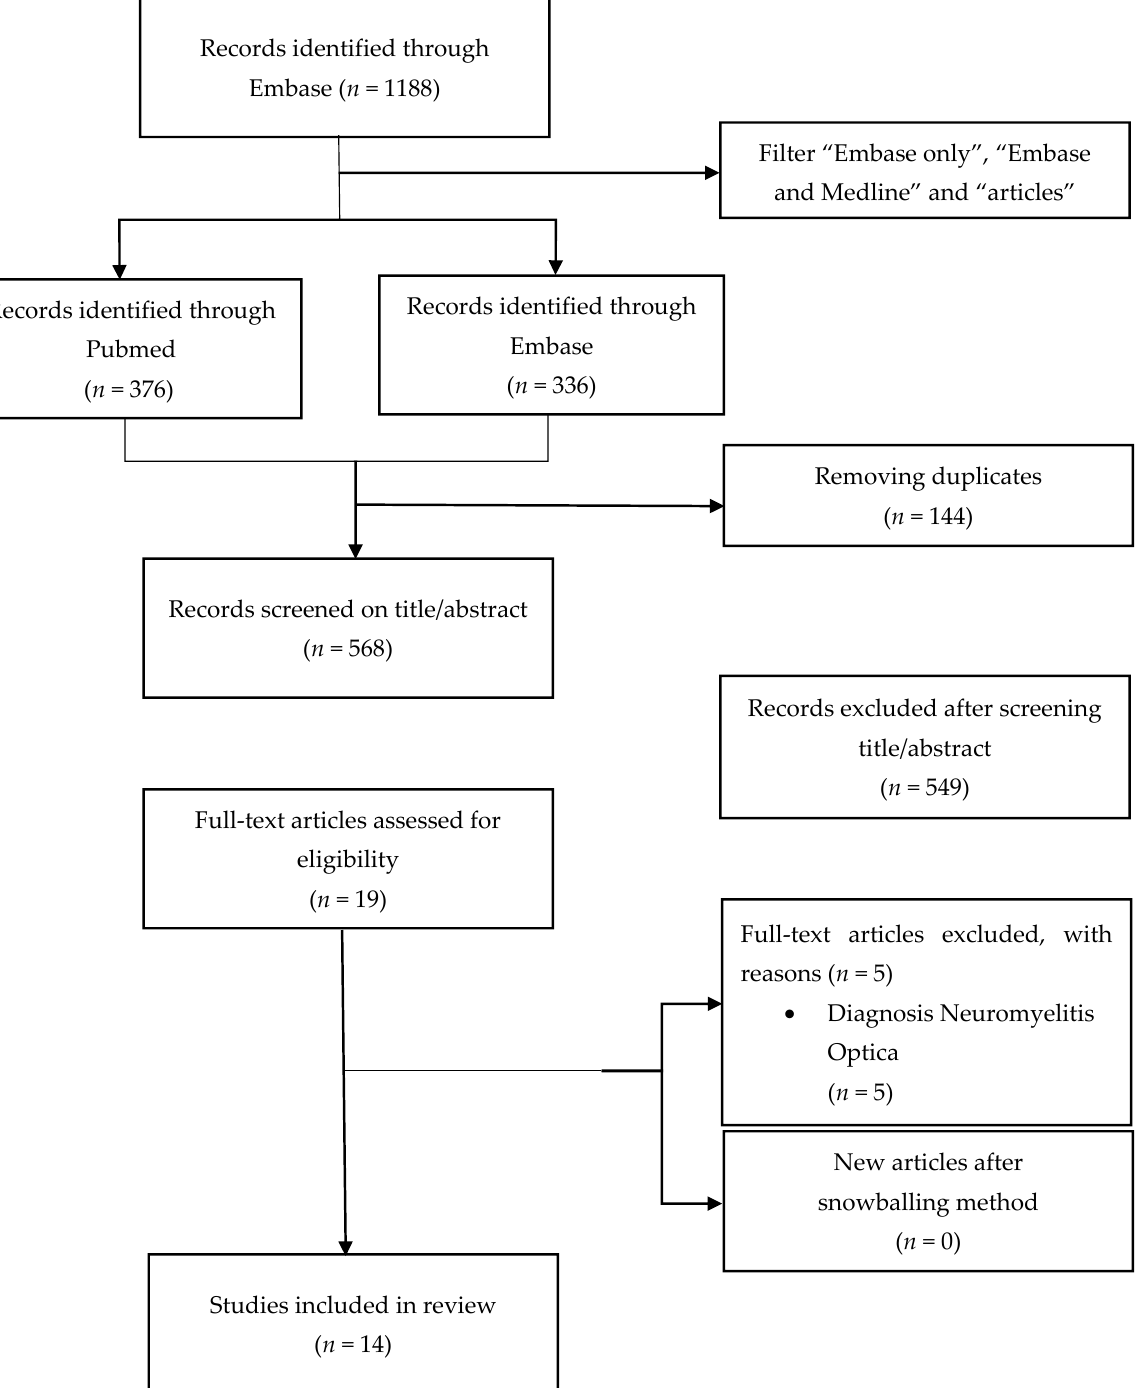
Figure 1. Flowchart of studies through the screening process.